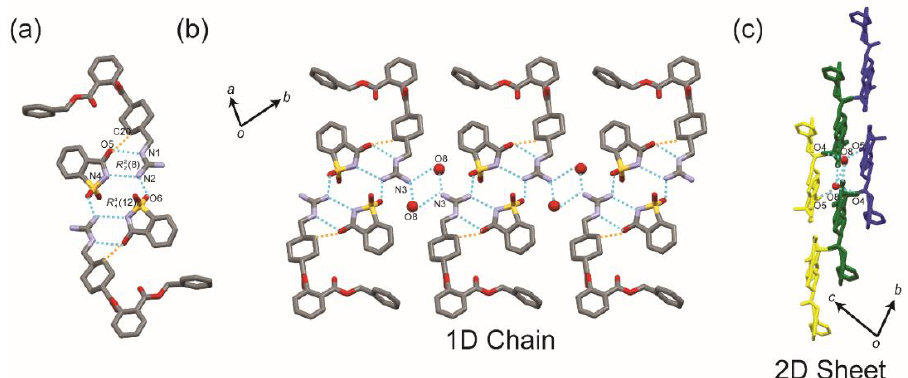
Figure 4. The hydrogen bond architecture in the BEX–SAC crystal. ( a ) The interaction involving two sets of cationic benexate and anionic saccharinate molecules and water constructs. ( b ) 1D chain structures parallel to the (110) plane. Each 1D chain (represented by different colors) interacts with each other to form ( c ) a 2D sheet structure. Conventional and non-conventional hydrogen bonds are drawn by dashed blue and orange lines, respectively. Hydrogen atoms have been omitted for clarity.